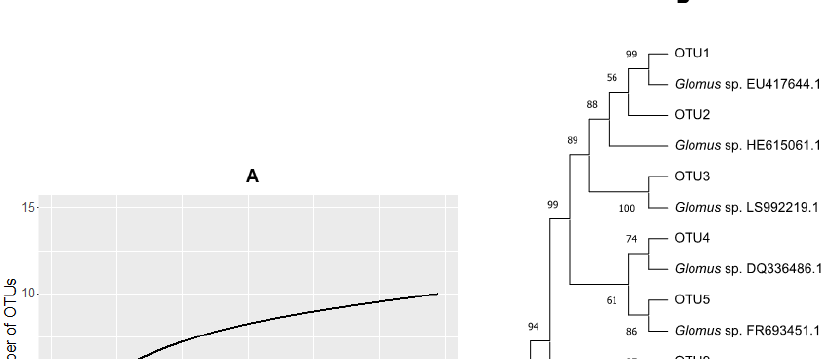
Figure 2. Changes in AMF spore densities and AMF relative abundance between the dry and wet seasons. The box plots show the distribution of AMF spore densities ( A ) and AMF relative abun- dance ( B ) in soil in the dry and wet seasons ( n = 6 biological replicates). Fungal relative abundances in soil between dry and wet seasons were determined by analysing ITS2 regions ( C ). Statistical anal- ysis was performed by Student’s t -test. Asterisks indicate significant differences ( p < 0.05).